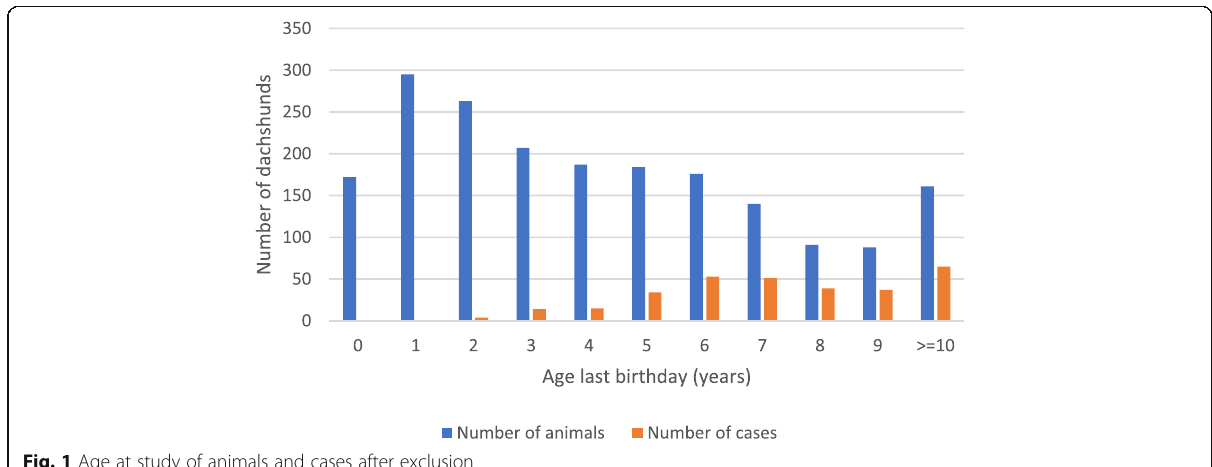
Fig. 1 Age at study of animals and cases after